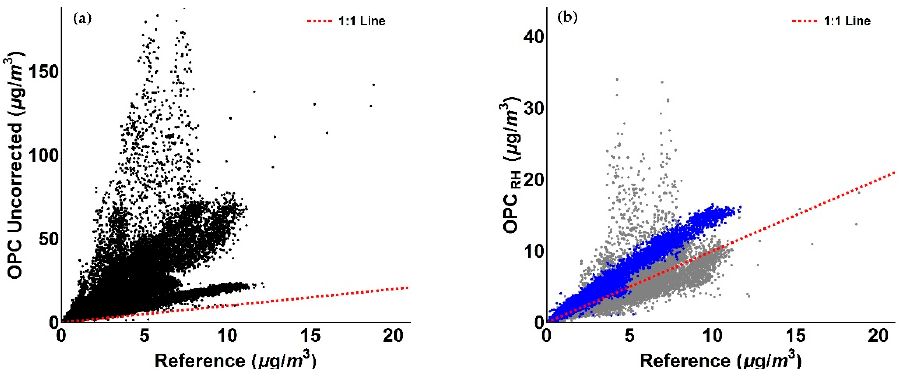
Figure 11. Figures illustrating the comparison of OPC measurements with reference data for PM 1 values. ( a ) Scatter plot of reference and uncorrected OPC PM 1 measurements relative to the period between 17 December 2017 and 16 January 2018; ( b ) Scatter plot of reference and OPC RH-corrected PM 1 measurements relative to the period between 17 December 2017 and 16 January 2018. The colour scheme reflects the blue and grey shaded areas in Figure 9c.